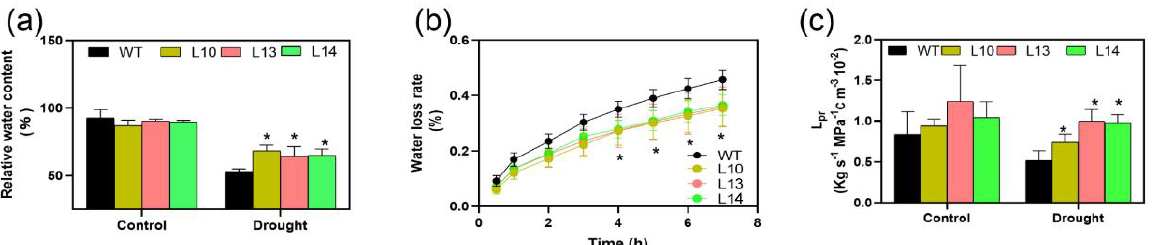
Figure 5. Relative water content in leaves and root hydraulic conductance. ( a ) Relative leaf water content of WT and PagPIP2;10ox lines after nine days of water deficit; ( b ) The water loss rate in detached leaves at room temperature; ( c ) Root hydraulic conductance after three days of treatment with 15% (m/V) PEG 6000. Data were analyzed with the Student’s t -test in the ANOVA program of SPSS (IBM SPSS17.0). * indicates a significant difference compared with the control ( * p < 0.05). Drought stress induces the accumulation of ABA and ROS, which promotes stomatal closure. To verify whether PagPIP2;10 modified the ABA-induced stomatal closure, the leaves from the WT and PagPIP2;10ox lines were treated with ABA, and the stomatal ap- erture was analyzed. The results show the stomatal aperture of both the overexpression lines and the WT lines decreased after 1 h and 2 h of ABA treatment, but the stomatal aperture of the PagPIP2;10ox lines was smaller than that of the WT lines (Figure 6a,b). This indicated that the stomatal closure of the overexpression lines was faster than that of the WT lines after ABA treatment. Further analysis using the H 2 DCFDA probe revealed that ROS was significantly enriched in guard cells of the PagPIP2;10ox lines compared with the WT plants after ABA treatment (Figure 6c,d). We also analyzed the stomatal conductance response to different light intensities and CO 2 concentrations. The results show the sto- matal conductance of the PagPIP2;10ox lines did not vary significantly with the WT lines (Figure 6e,f).